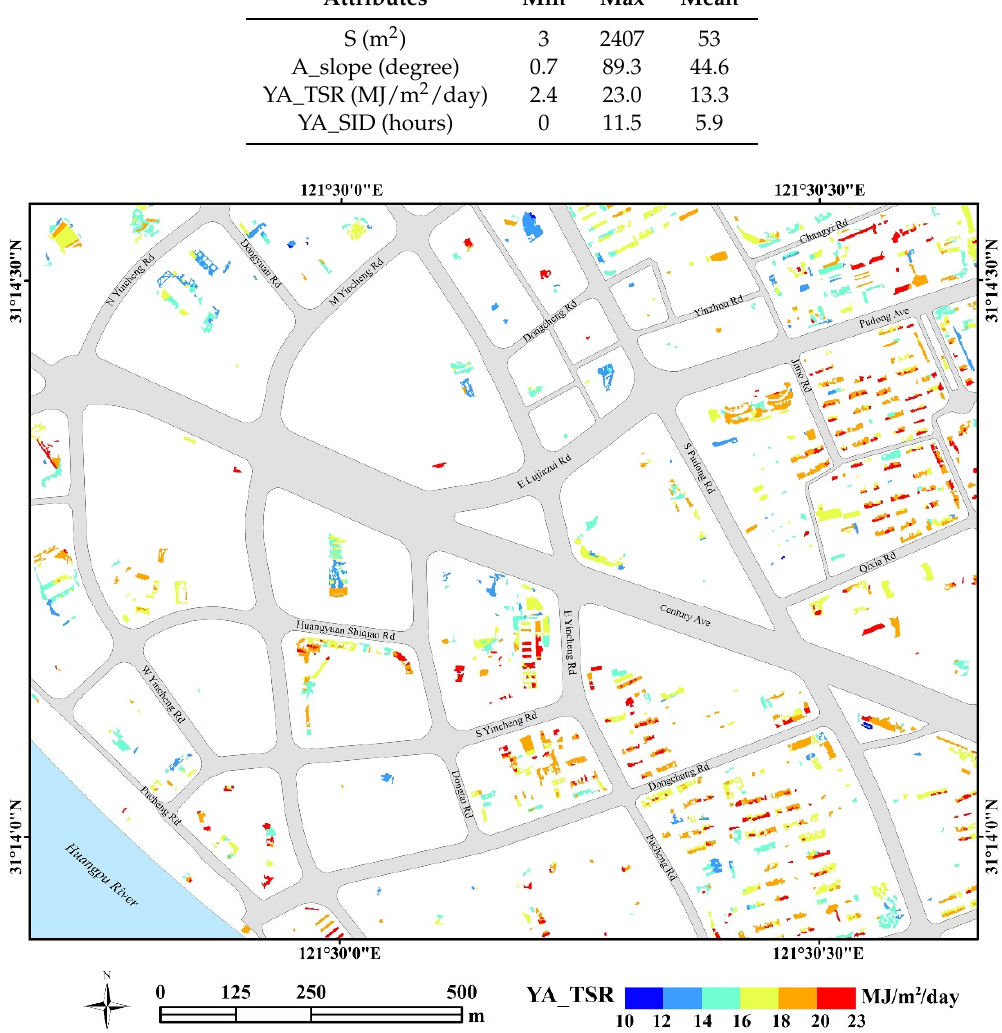
Figure 10. The distribution and yearly average total solar radiation of suitable roof planes in the Lujiazui region. Lujiazui